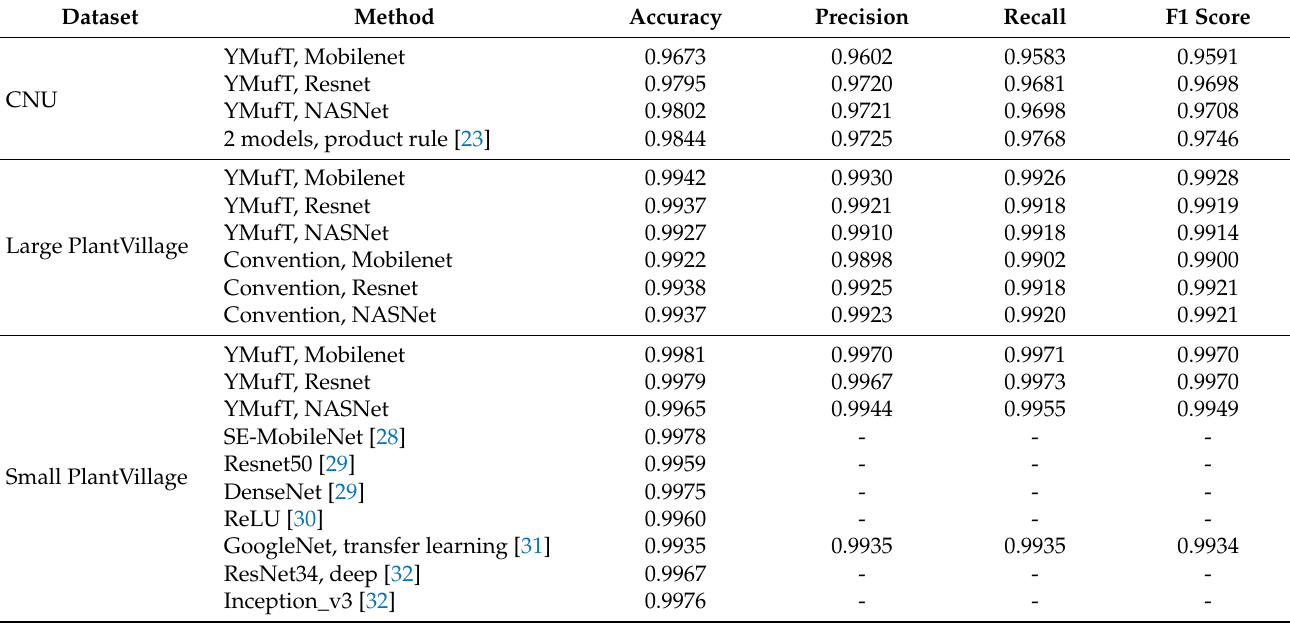
Figure 22. Precision, recall, and F1 score on each species in the PlantSeedlings dataset. The blue bars indicate the ratio of the number of samples of a species to the maximum number of samples in all species. Table 5. Performance comparison between the YMufT strategy and other